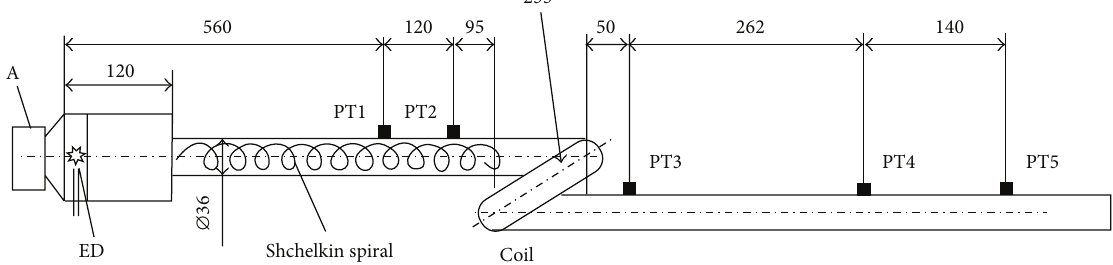
Figure 11: Schematic diagram of Shchelkin spiral and a coil inside the detonation tube